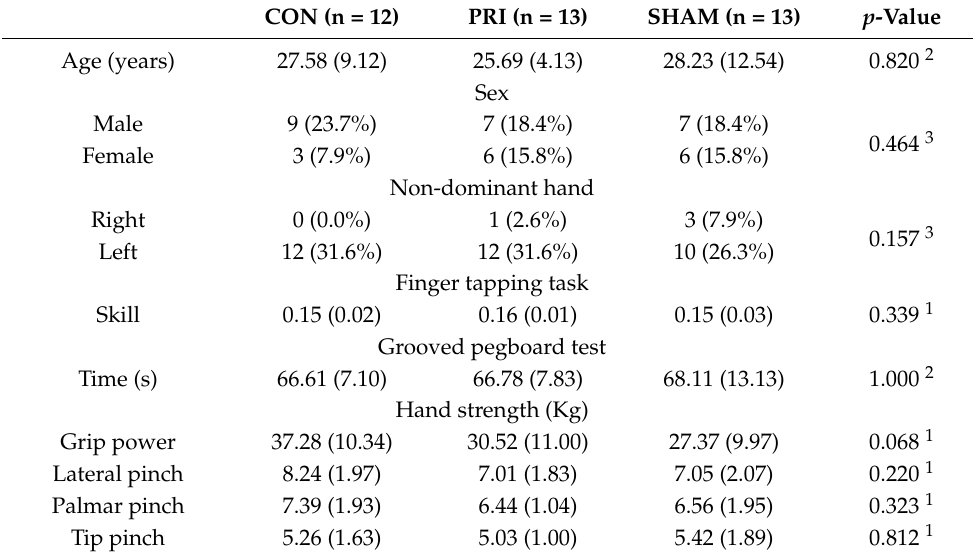
Table 1. Comparison of the baseline demographic characteristics and motor task performance be- tween the three groups. Data are presented as frequencies (%) and means (standard deviations, SD).